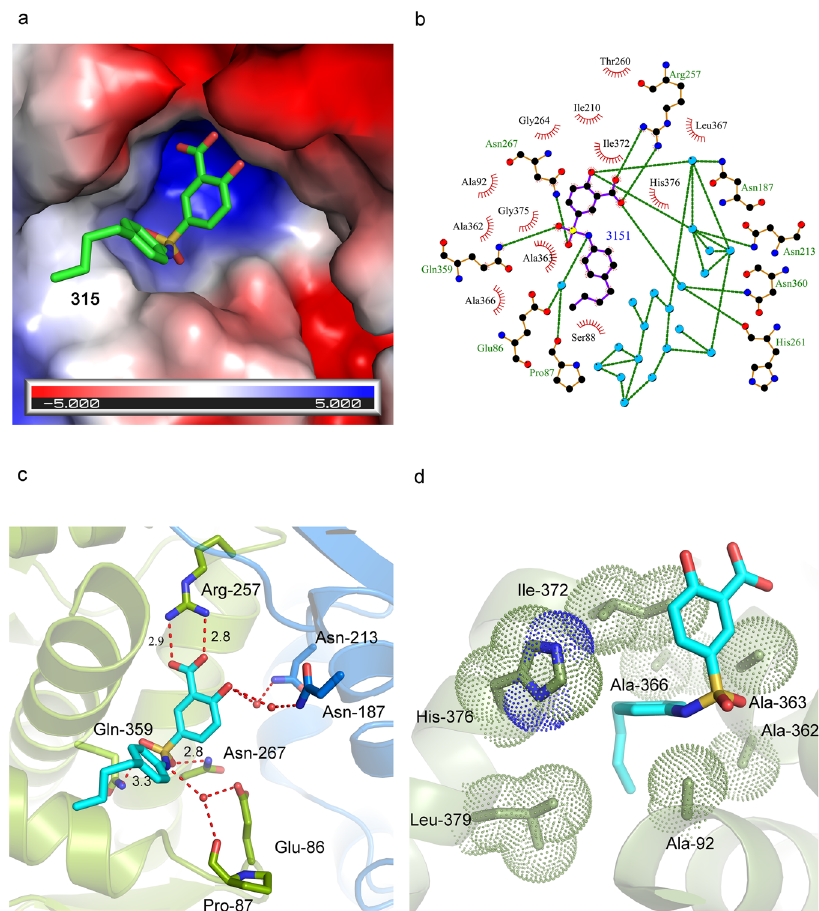
Fig. 5 315 binds in the mevalonate binding pocket in efHMGR. a Electrostatic potential map showing 315 binding in the mevalonate binding pocket present at the dimer interface. The benzoic acid moiety is tucked inside a pocket lined with charged residues while the butylphenyl group of 315 is accommodated in a hydrophobic environment. b Ligplot diagram showing interactions between 315 and the mevalonate pocket residues in efHMGR. Hydrogen bond interactions are represented by green dashed lines, waters as cyan spheres and hydrophobic contacts as brown semicircles. c Hydrophilic interactions stabilize 315 in the mevalonate binding pocket of efHMGR. The large domain residues, Glu-86, Pro-87, Arg-257, Asn-267 and Gln-359, colored green, interact with the ligand via direct and water-mediated hydrogen bond interactions. The small domain residues from the adjacent monomer, Asn-187 and Asn-213, colored blue, also interact with the ligand via water molecules. Red spheres represent water molecules. Red dashes represent the hydrogen bond interactions with the numbers indicating the hydrogen bond distances in Å. d Hydrophobic interactions also stabilize 315 in the active site. Hydrophobic residues such as Ala-92, Ala-362, Ala-363, Ala-366, Ile-372 and His-376 pack against the hydrophobic butylphenyl group and stabilize the ligand. The residues are represented as sticks with Van der Waals radii as dotted spheres. (pH 7.0) with constant stirring at 4 °C for 1h and subsequently pelleted down by Table 2 List of hydrogen bond interactions between 315, the centrifuging at 14,000 rpm for 20min. The pellet was resuspended in 5mM HEPES efHMGR enzyme and water